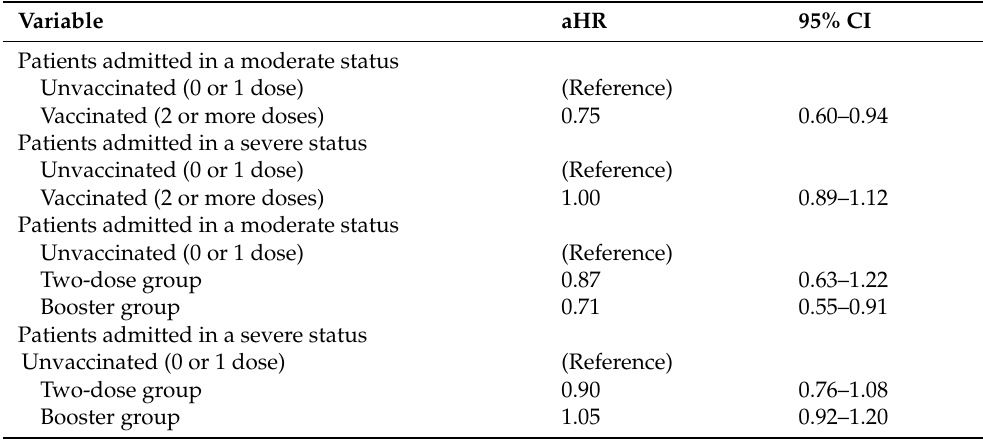
Table 2. Estimated regression coefficients with consideration of the interaction term of vaccination and the severity of disease with adjustment for